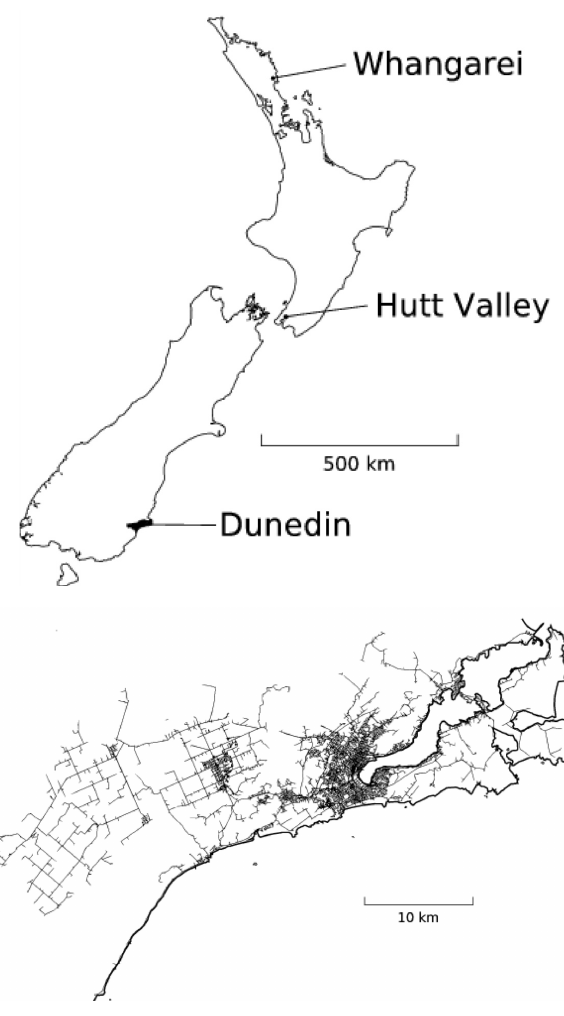
Fig. 1. Map of New Zealand on the left showing the location of Dunedin and other electrical suppliers using a 1050Hz ripple con- trol signal. Dunedin’s electrical network is shown in detail on the